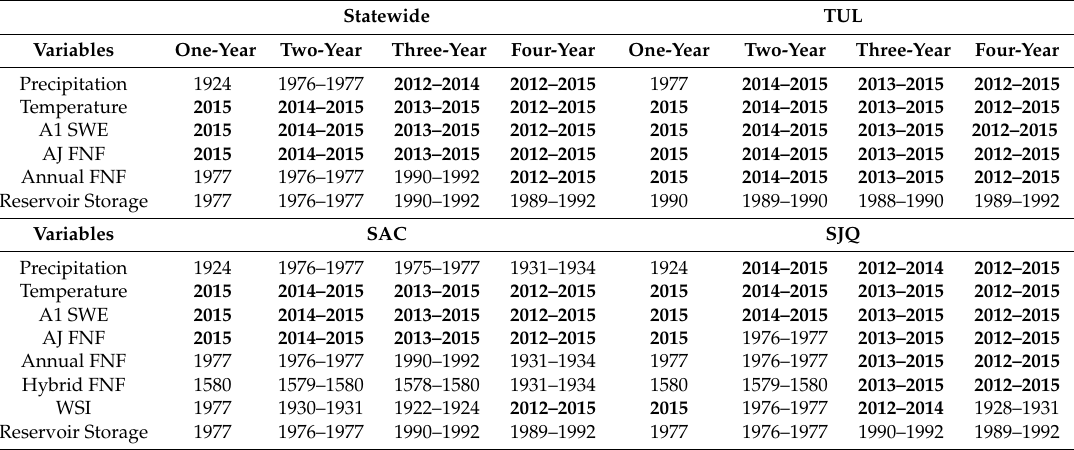
Table 5. Periods with hydroclimatic variables ranked first in the record period 1 .